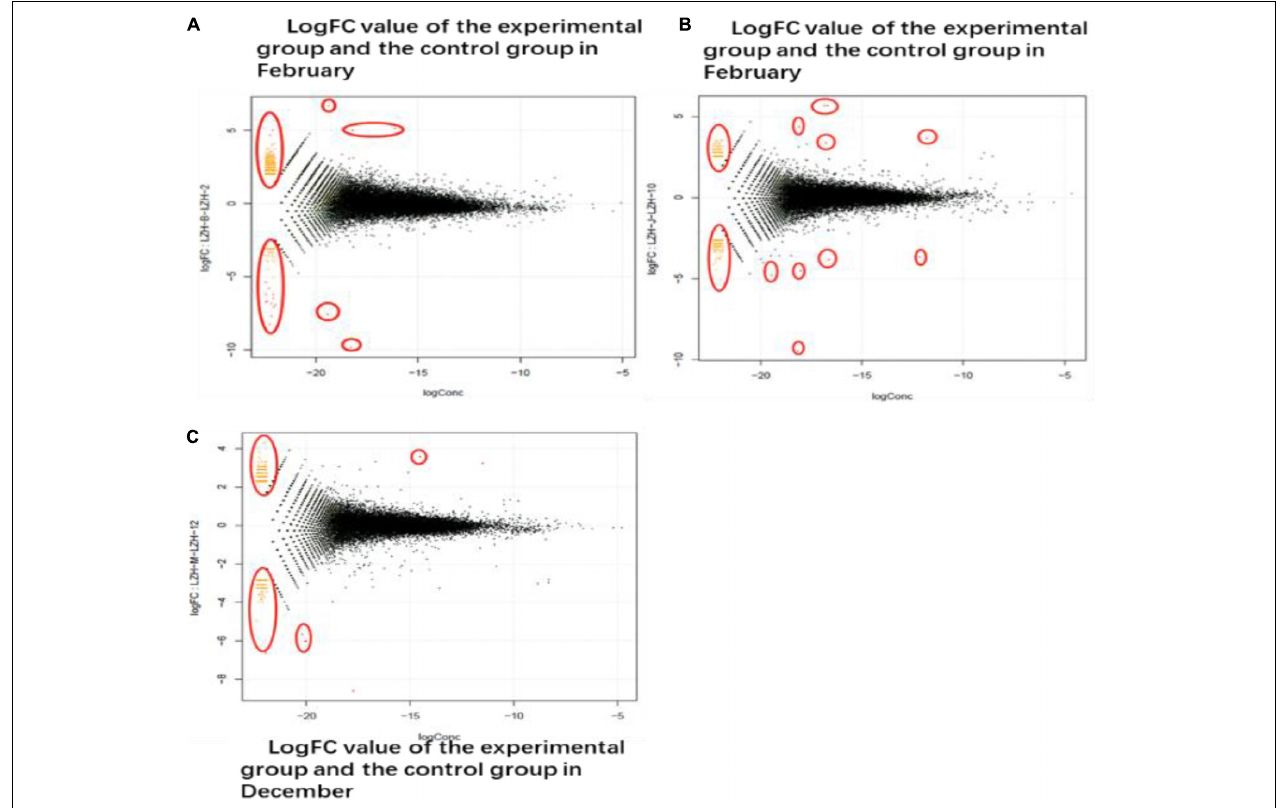
FIGURE 4 | DEG different period of cashmere. (A) LogFC value of the experimental group and the control group in February. The transcriptome data of the experimental group and the control group in February, October, and December were screened for differentially expressed genes. The co-expressed genes were on the outside and the different genes were on the inside. (B) October LogFC value of the experimental group and the control group. In October, 641 genes were screened out, of which 178 were down-regulated and 463 were up-regulated. (C) The LogFC value of the experimental group and the control group in December. In December, 305 differentially expressed genes were screened, among which 138 up-regulated genes had 167